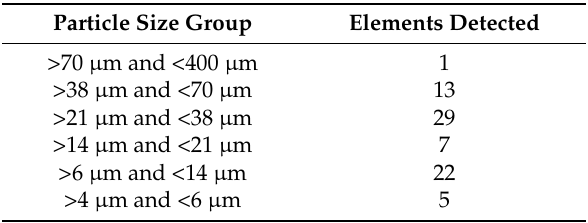
Figure 25. Result of processing the image of the Figure 21 with the particle detection algorithms. The processed image overlays the detected particles. Table 6. Particle classification results according to ISO 4406 size groups for the sample image of Figure